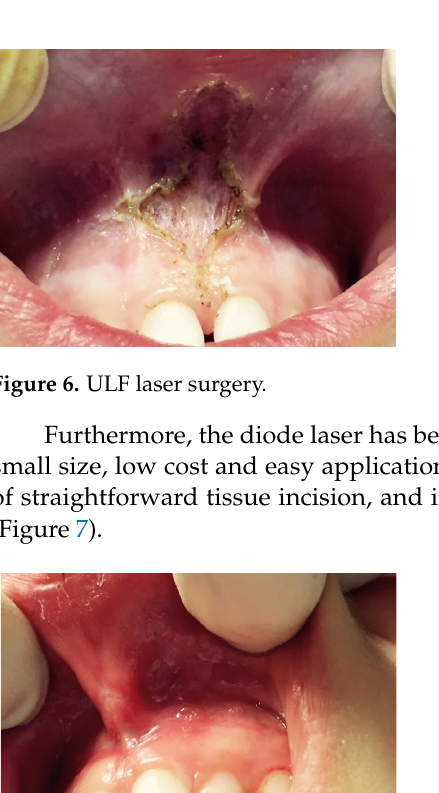
Figure 5. Laser frenectomy.